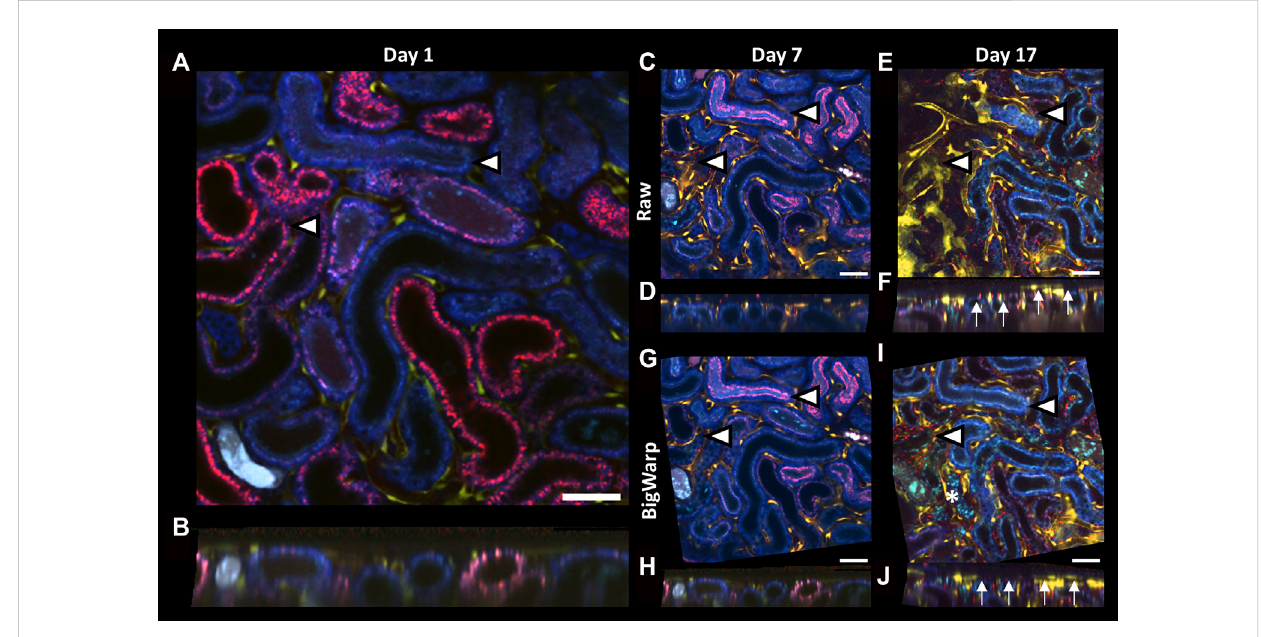
FIGURE 5 Landmark-based 3D registration of serial intravital microscopy data using BigWarp. (A – J): Representative 2D images (A,C,E,G,I) and xz cross sections (B,D,F,H,J) of volumetric serial intravital 2-photon microscopy data acquired in a Cdh5-tdTomato mouse kidney at day 1 (A,B) , 7 (C,D,G,H) and 17 (E,F,I,J) after ischemia reperfusion injury (IRI) before (C – F) and after (G – J) 3D registration using BigWarp. Arrowheads in 2D images indicate 2 representative tubules in serial data to demonstrate the effect of 3D registration and to reference equivalent locations in the fi eld of view. Thus, severe tissue remodeling and tubule atrophy development at day 17 (I, asterisk) resulted in tissue shrinkage and changes in orientation that prevent simultaneous 2D displaying of tissue structures that used to be in the same plane (E, arrowheads). Note tissue shrinkage in day 17 xz cross section (F, arrows). In contrast, 3D registration using BigWarp successfully aligned tissue structures in serial imaging data (J, arrows). Scale bars = 50